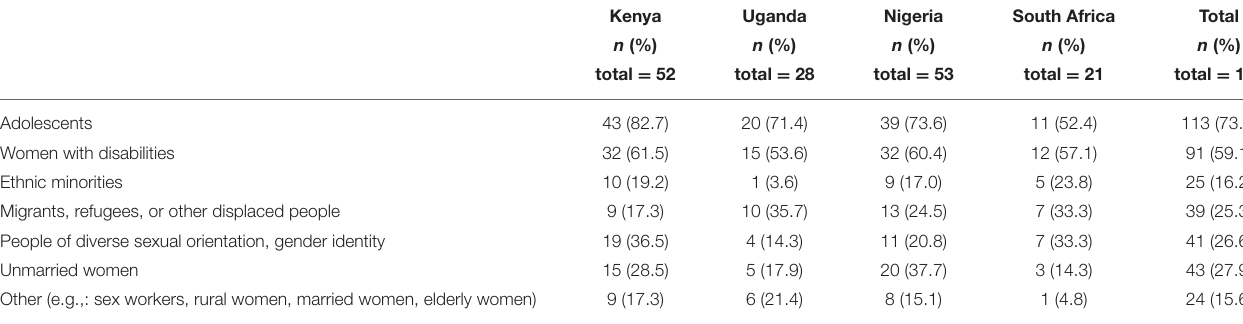
TABLE 4 | Groups identified by respondents as being more severely impacted by GBV during the COVID-19 pandemic.